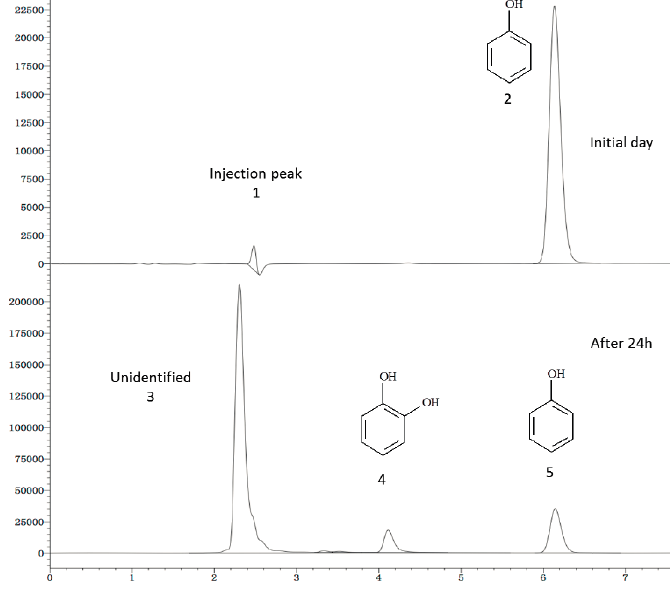
Figure 7. HPLC profile of phenol degradation by Halomonas sp. strain 4-5 at 10% ( w / v )